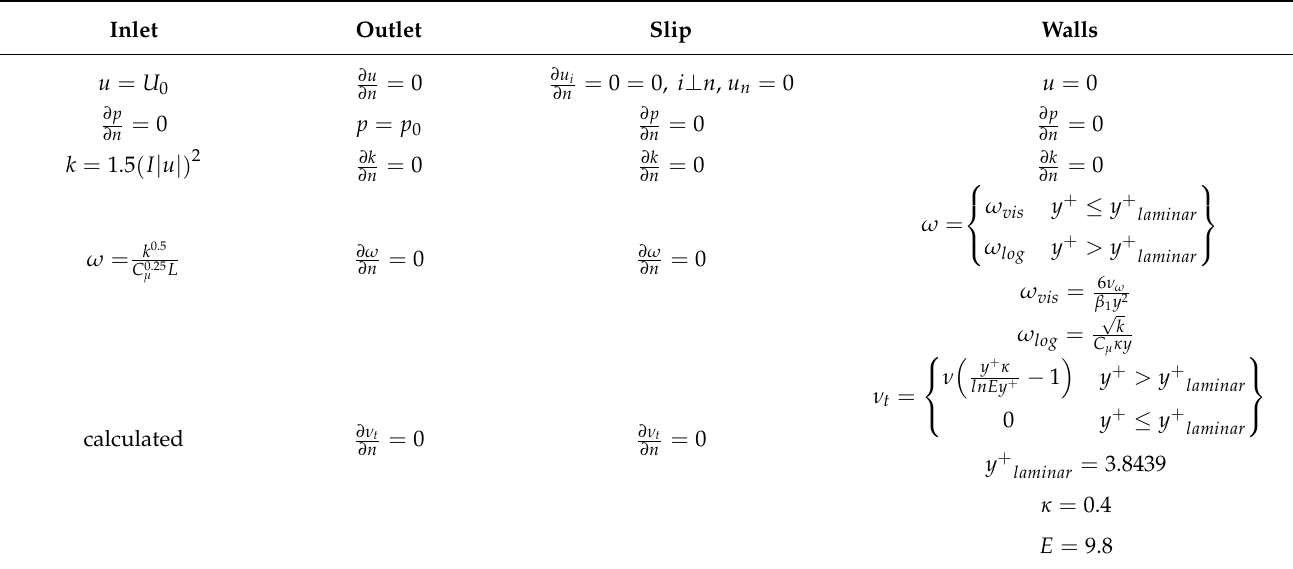
Table 1. Boundary conditions of the